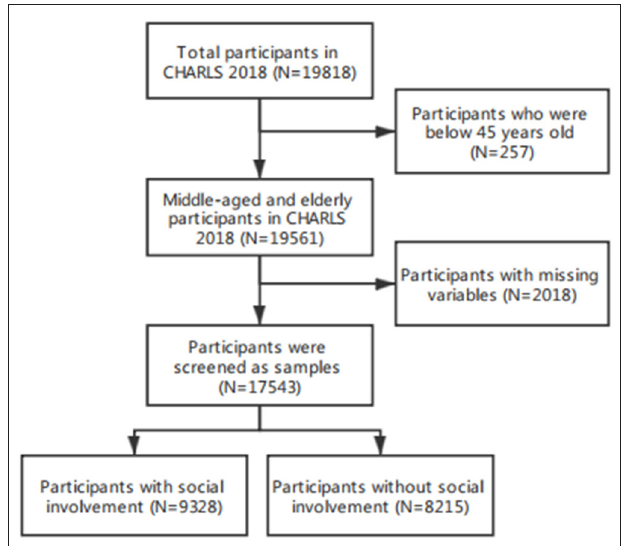
FIGURE 1 | Flowchart of the observation’s selection and classification; CHARLS, (China Health Retirement Longitudinal